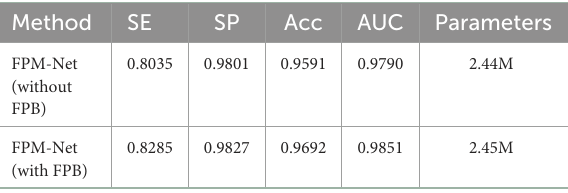
TABLE 1 Details of the testing and specifications of all three used datasets in our method.